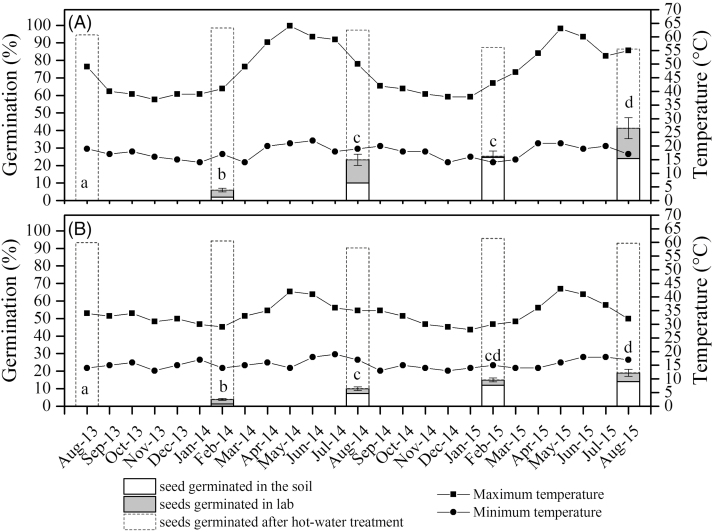
Maximum and minimum soil temperature in °C recorded at 3 and 7 cm below the soil surface at the burial site between August 2013 and August 2015. Seeds of Adenanthera pavonina buried at (A) 3 cm depth and (B) 7 cm depth were exhumed every 6 months from soil and assessed for germination at 20/25 °C. Germination of seeds buried in soil, germinated in the laboratory and germinated after dipping in boiling water are shown in percentages. Different lower-case letters indicate a significant difference in percentage of seeds germinated in the field and laboratory (combined).